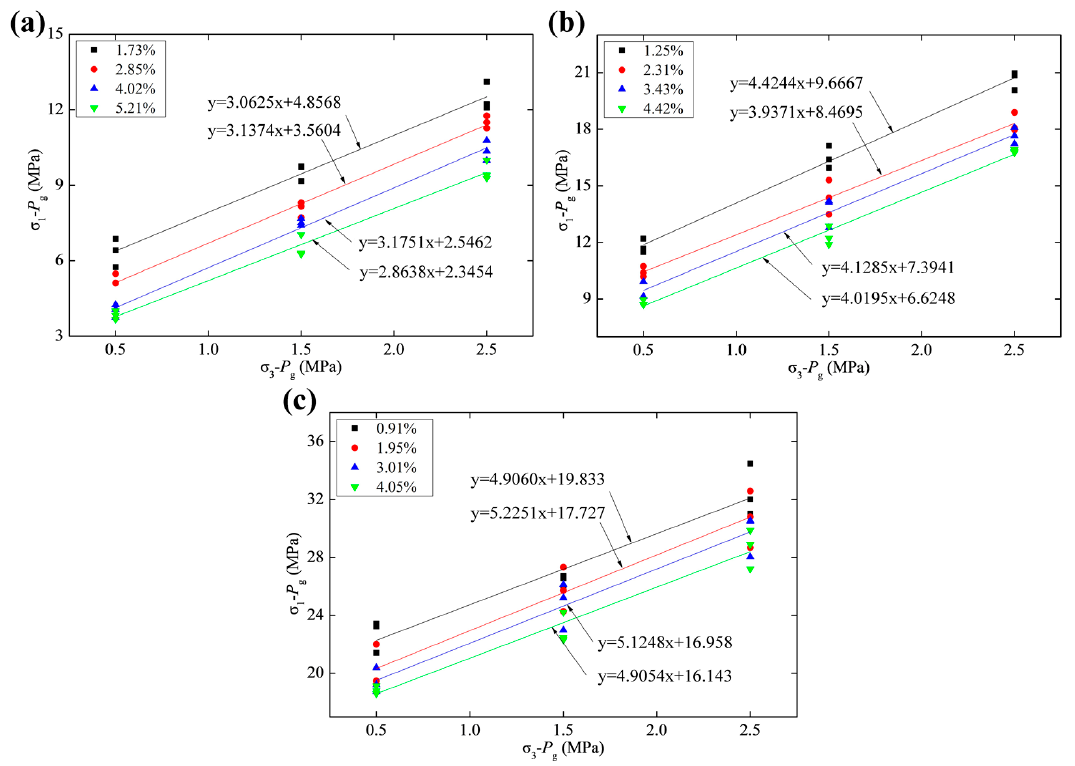
Figure 8. Relationship between ( σ 1 − P g ) and ( σ 3 − P g ): ( a ) Songzao; ( b ) Pingdingshan; and ( c ) Tashan. According to Equation (23), the internal friction angle and effective cohesive force for coal samples of the same moisture content can be calculated from the slope and intercept of these linear plots, as given by Equation (24).